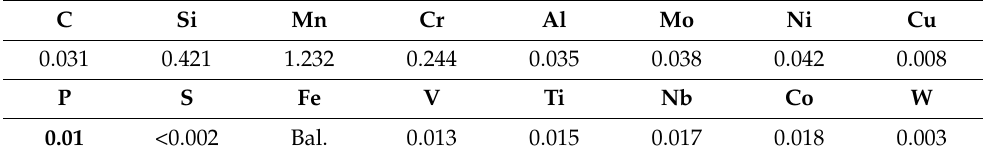
Table 1. Chemical composition of steel Hardox 400 (% wt.).